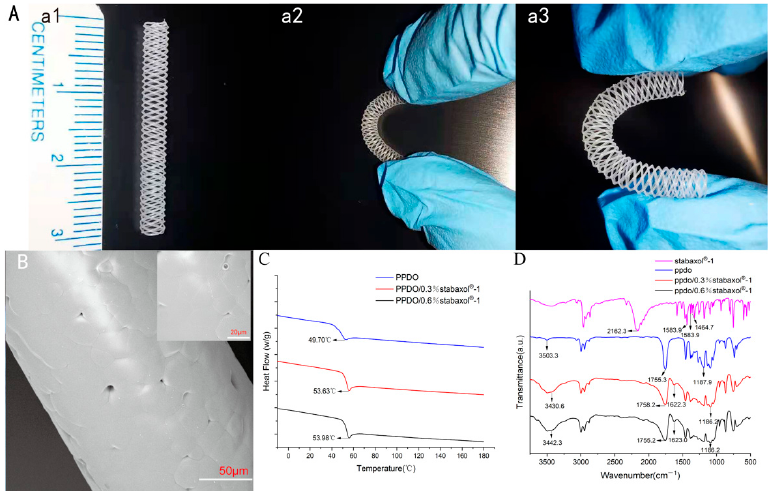
Figure 2. Characterization of PPDO, PPDO/0.3% stabaxol ® -1, and PPDO/0.6% stabaxol ® -1 BRSs. ( A ) BRSs with dimensions of 30 mm × 3 mm with significant flexibility. ( B ) Sectional view of PPDO BRS captured by electron microscopy (SEM); ×1100. Scale bar: 50 μ m, ×3200. Scale bar: 20 μ m. ( C ) DSC and ( D ) FT-IR spectra of indicated BRSs.